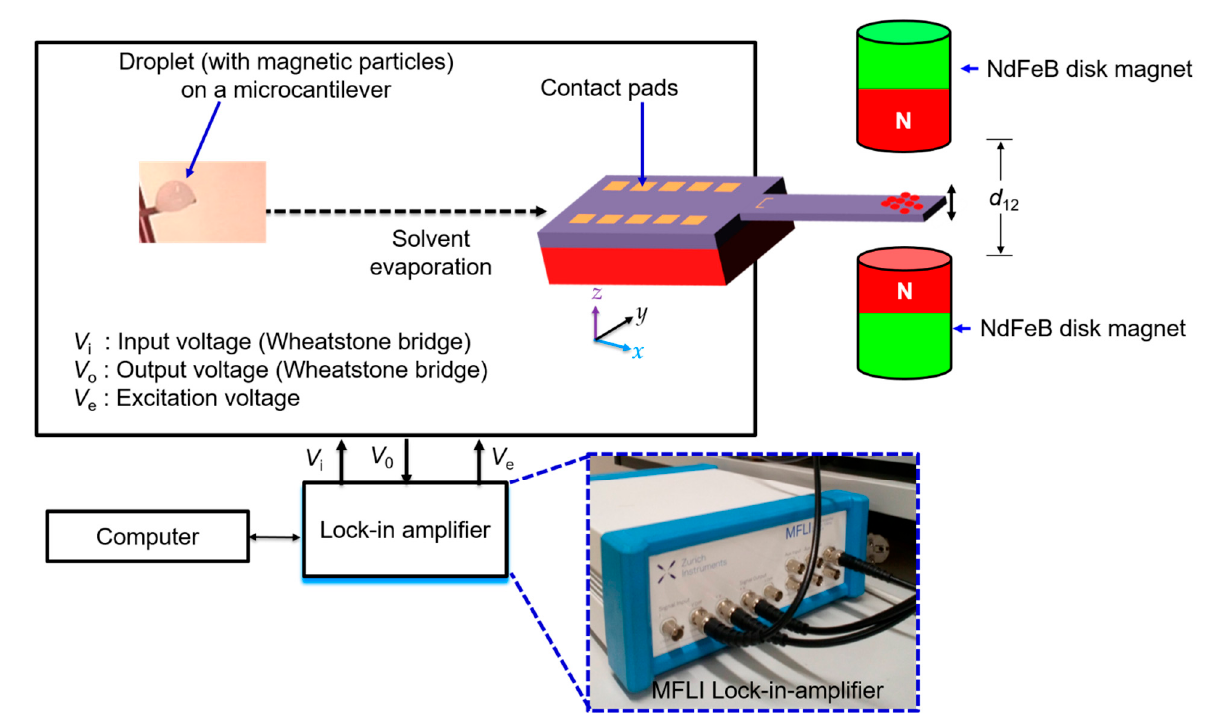
Figure 6. Magnetic force gradient detection setup, mainly comprising of a cantilever sensor (plus aligned magnetic particles), lock-in amplifier and pair of neodymium permanent magnets.